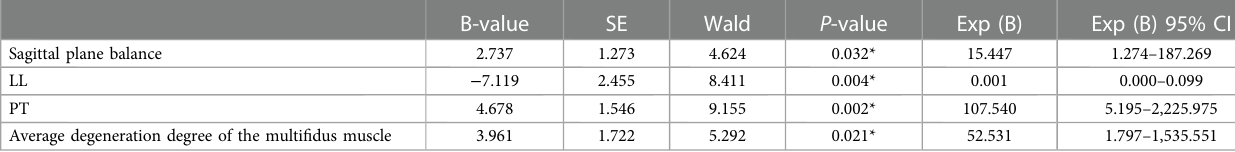
TABLE 7 Multivariate logistic regression analysis of signi fi cantly different variables for the factors associated with PI-LL mismatch. B-value SE Wald P -value Exp (B) 95% CI